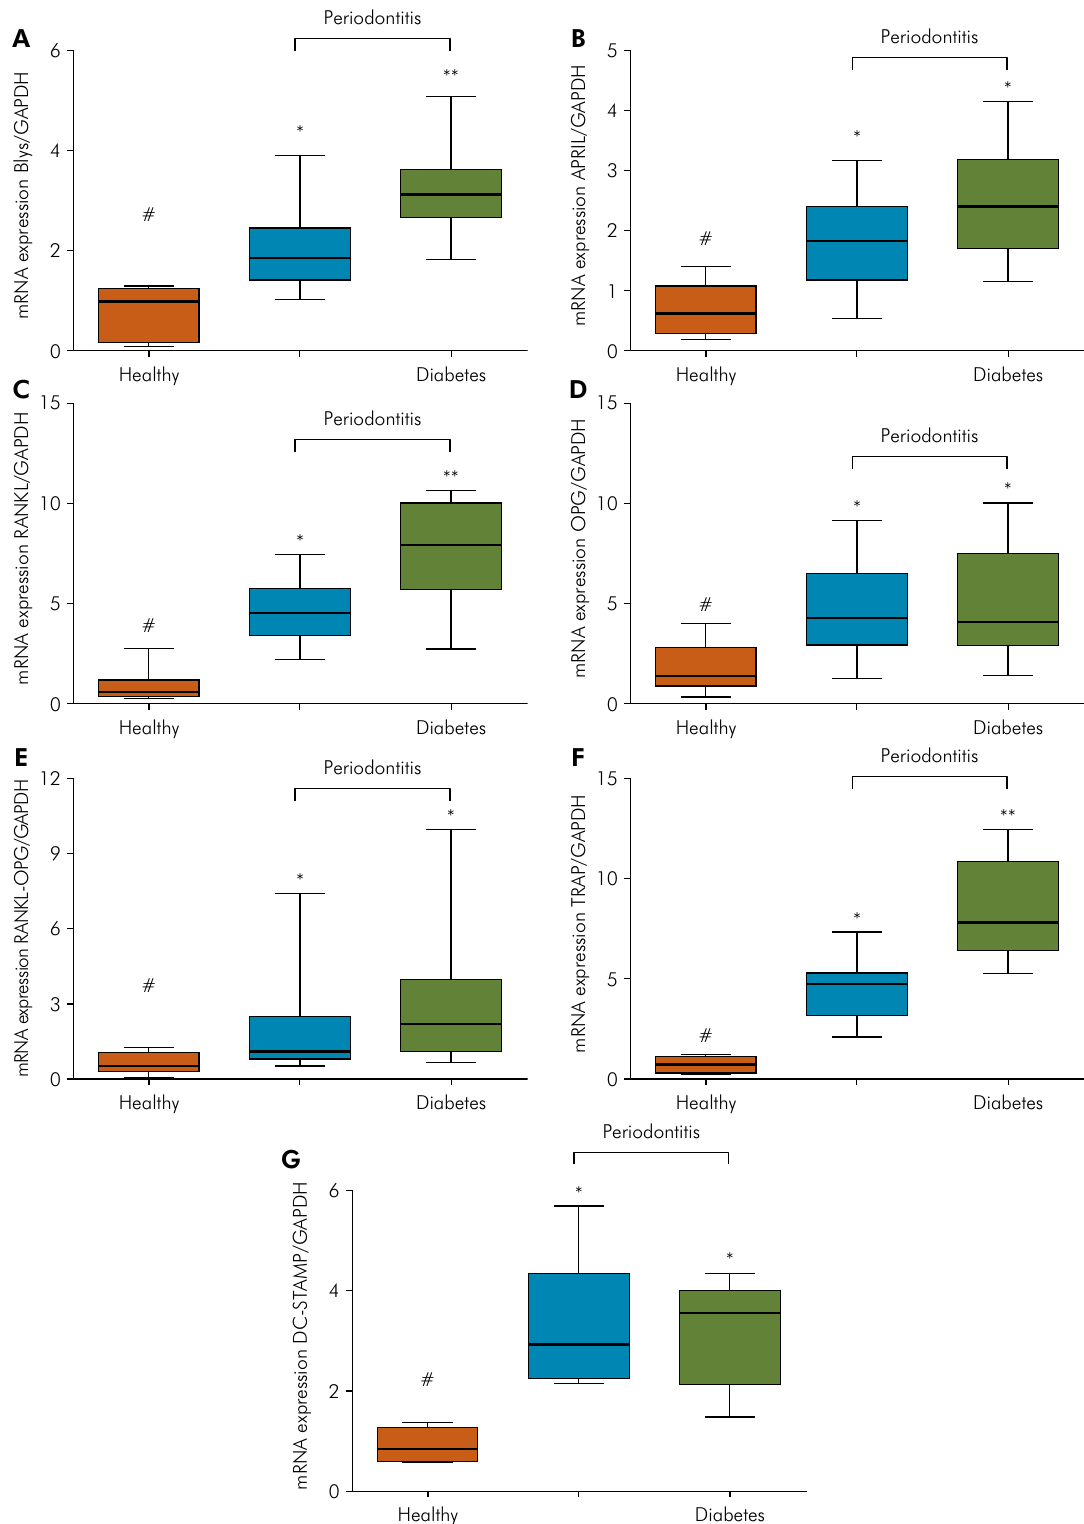
Figure. Relative expression of genes. qPCR analysis of BLyS (A), APRIL (B), RANKL (C), OPG (D), RANKL/OPG (E), TRAP (F) and DC-STAMP (G) expression on mRNA extracted from gingival tissue of healthy and periodontitis patients, associated or not with diabetes mellitus (DM). Different symbols indicate statistical significance amongst the groups (p <